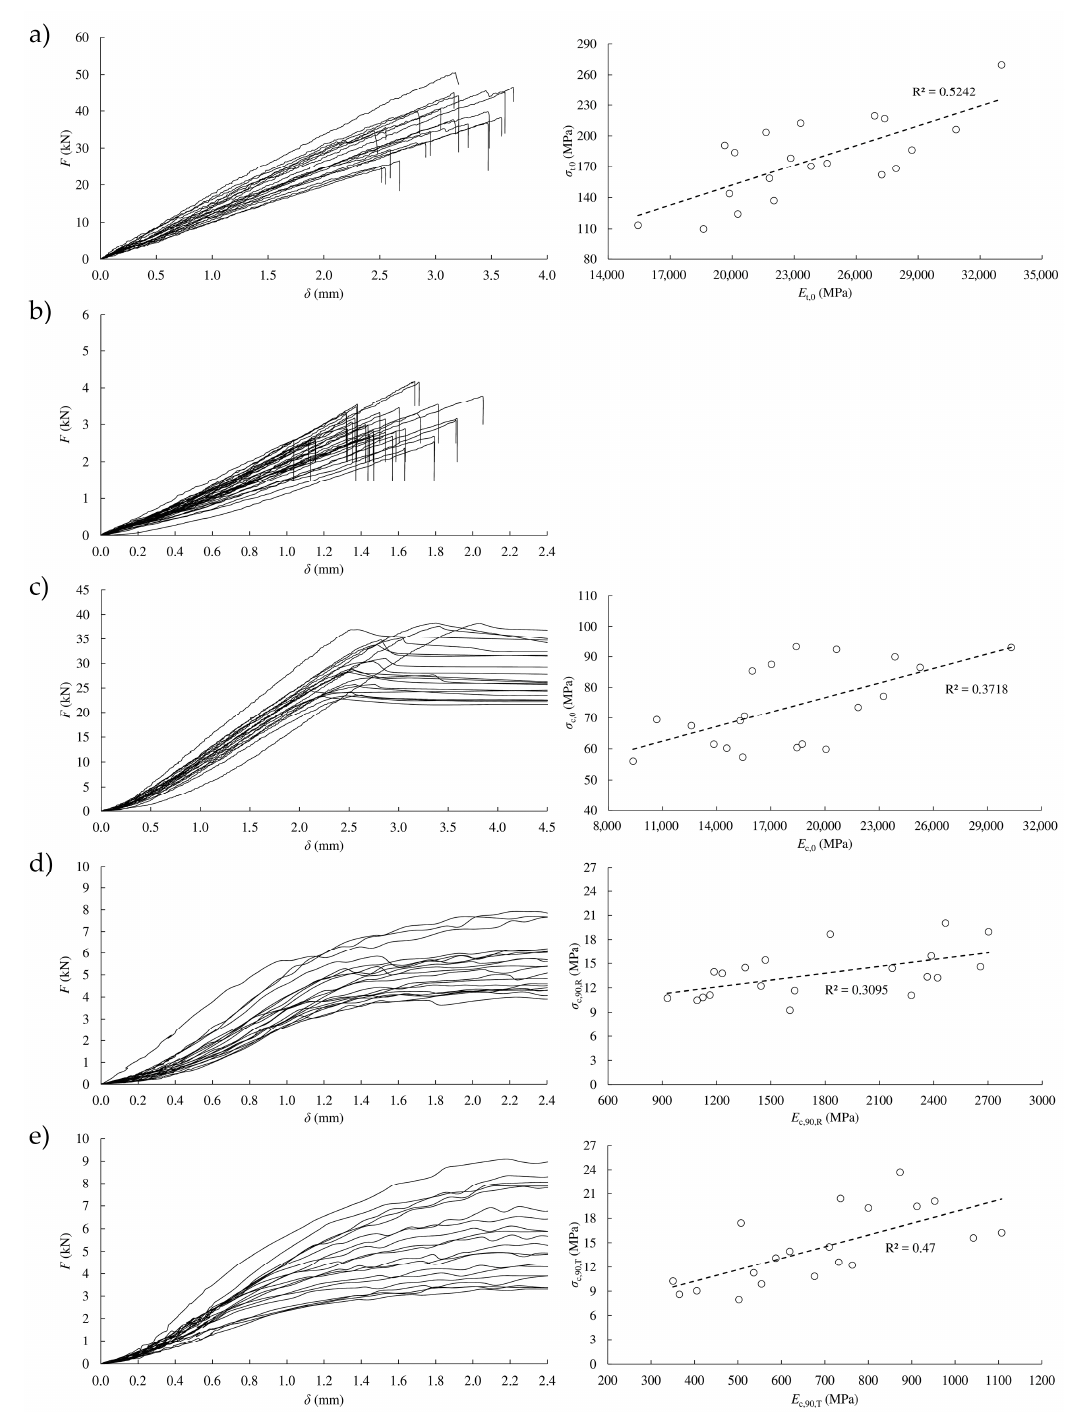
Figure 3. Load-displacement curves (left column) and correlation between ultimate stress and modulus of elasticity (right column): ( a ) tension parallel to grain; ( b ) tension perpendicular to grain; ( c ) compression parallel to grain; ( d ) compression perpendicular to grain in radial direction; ( e ) compression perpendicular to grain in tangential